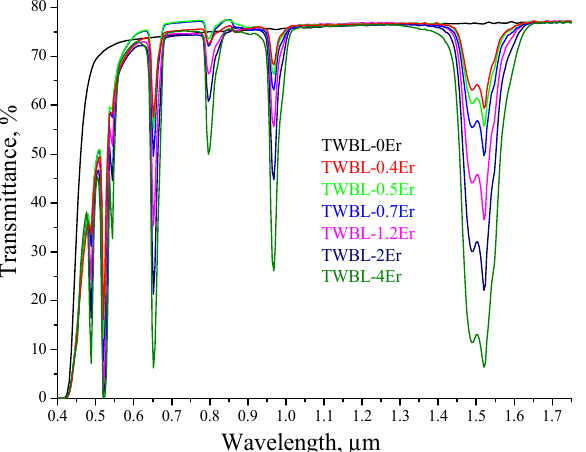
Figure 3. Visible and near-IR transmission spectra of TeO 2 -WO 3 -Bi 2 O 3 -(4-x)La 2 O 3 -xEr 2 O 3 glass samples 0.2 cm thick, x = 0; 0.4; 0.5; 0.7; 1.2; 2; 4 mol%.